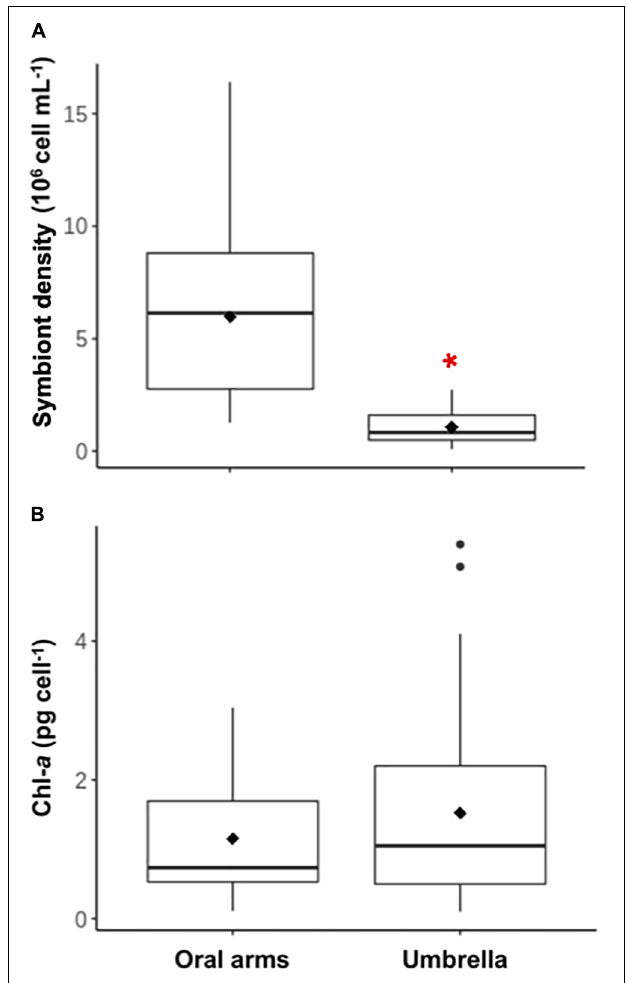
FIGURE 3 | Cell density and chlorophyll a content of Symbiodiniaceae isolated from C. tuberculata . (A) Symbiodiniaceae density within the jellyfish orals arms and umbrella. (B) Chlorophyll a (Chl a ) concentration of Symbiodiniaceae isolated from the oral arms and the umbrella. Red asterisk shows significant